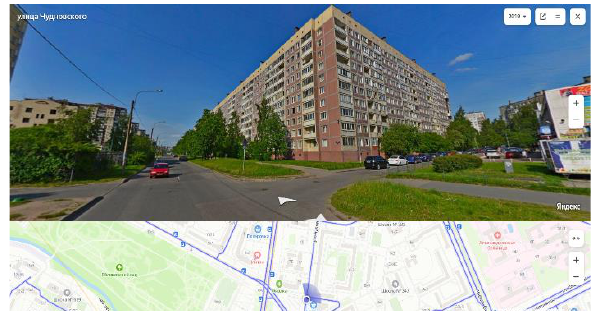
Figure 2 . Overview image of buildings No. 8/1 and 8/2 on Chudnovsky Street.